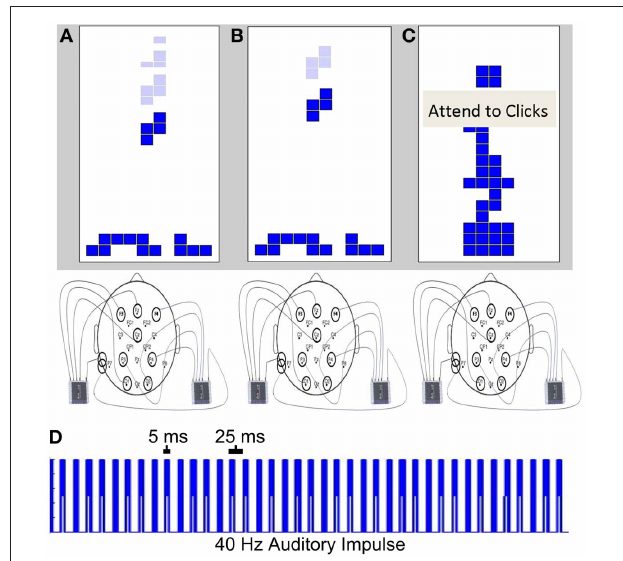
FIGURE 1 | SSAEP conditions. Individuals participated in a difficult version of Tetris ( A , condition 1), an easy version of Tetris ( B , condition 2), or attended to the auditory stimulus ( C , condition 3). A 40Hz auditory stimulus was presented to the subject during each condition, generating a 40Hz SSAEP response. The stimulus consisted of a series of 5ms square waves with a 25ms interval between the onset of each pulse (D)